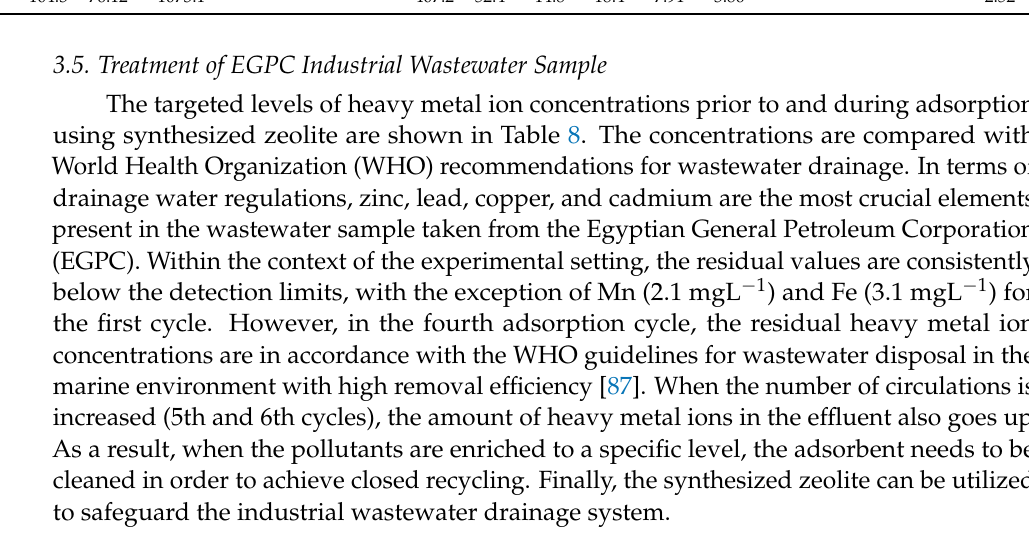
Table 8. Applying the synthesized zeolites for removing heavy metal ions from EGPC industrial wastewater